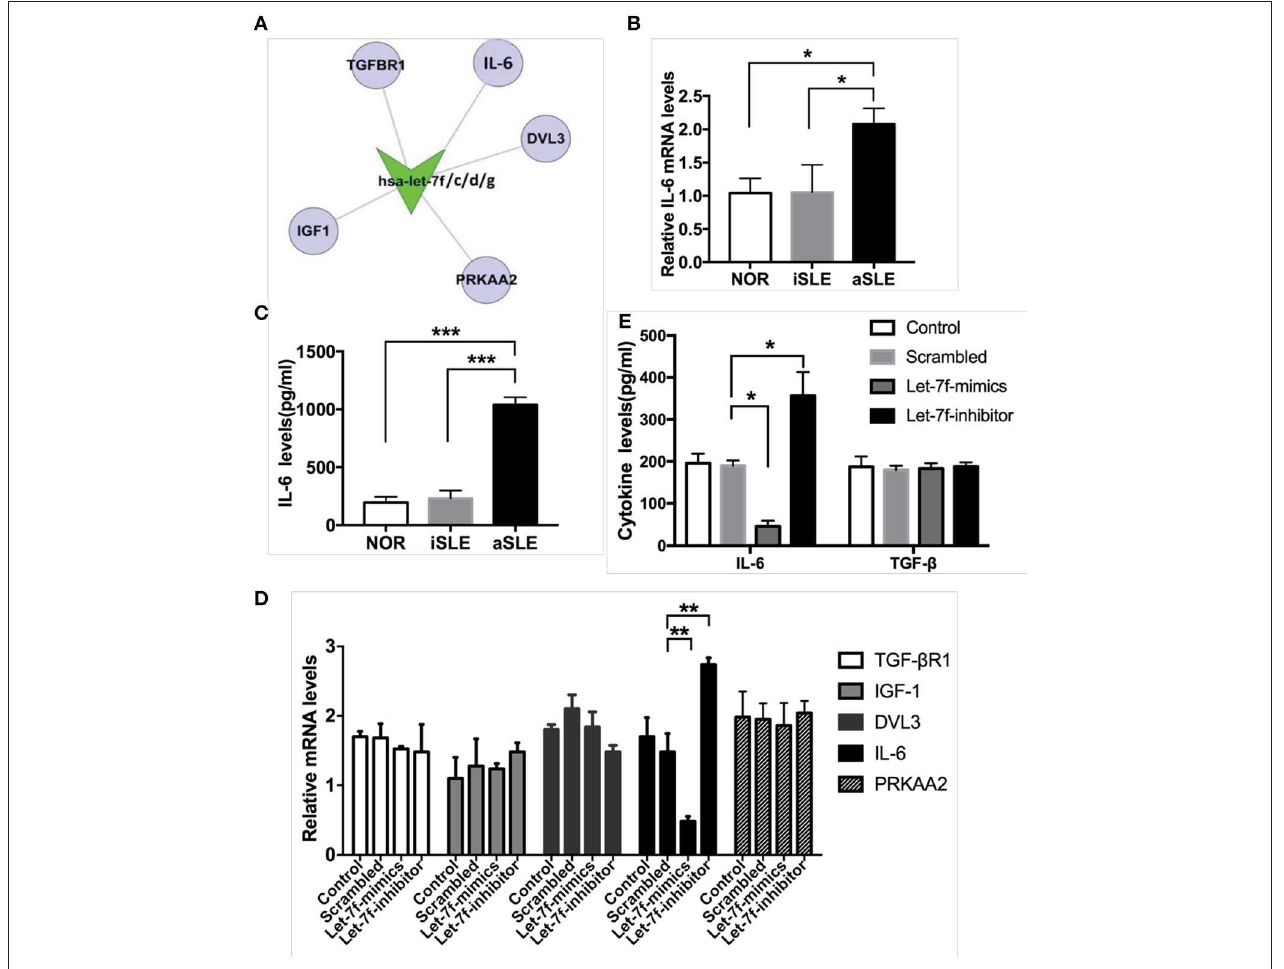
FIGURE 2 | Let-7f could modulate IL-6 expression levels in BM-MSCs. (A) Predicted let-7 family targets by two computational methods, Targetscan and PITA. (B) IL-6 gene expressions in BM-MSCs from aSLE patients, iSLE patients and NOR. (C) aSLE BM-MSCs produce more IL-6 than that of BM-MSCs from NOR and iSLE patients after culturing for 24h. (D) Gene expressions of predicted target of let-7 family in let-7f related oligonucleotide transfected BM-MSCs. (E) IL-6 and TGF- β protein levels in cultured supernatants of various let-7f related oligonucleotide transfected BM-MSCs. All data are mean ± SEM. For b-c, n (aSLE) = 9, n (iSLE) = 6, n (NOR) = 10; For d-e, n = 6. * P < 0.05, ** P < 0.01, *** P <